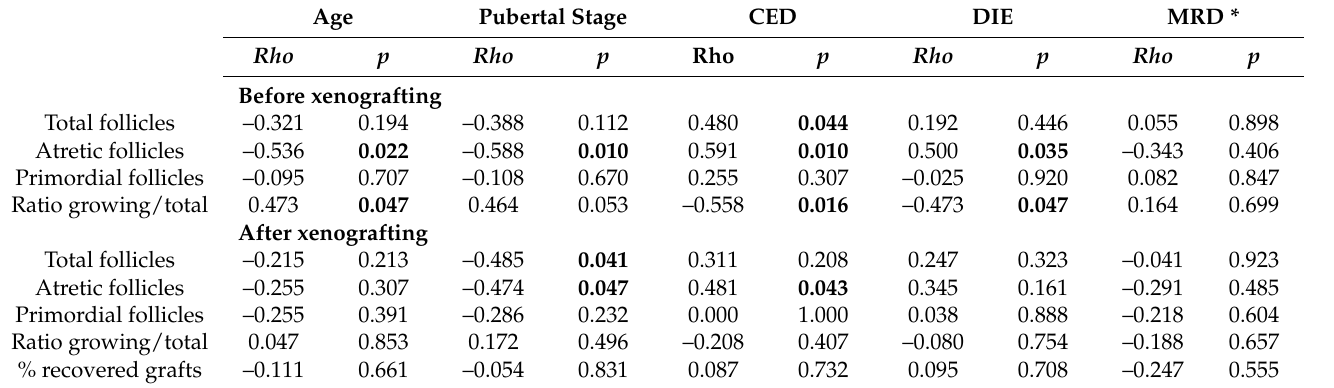
Table 3. Spearman’s rank correlation analysis of age, pubertal stage, cumulative Cyclophosphamide- Equivalent Dose (CED), cumulative anthracycline dose (DIE) and ovarian minimal-residual leukemia (MRD) and their association with follicle numbers per graft and ratio of growing/total follicle numbers and percentage proportion of recovered grafts before and after xenografting.